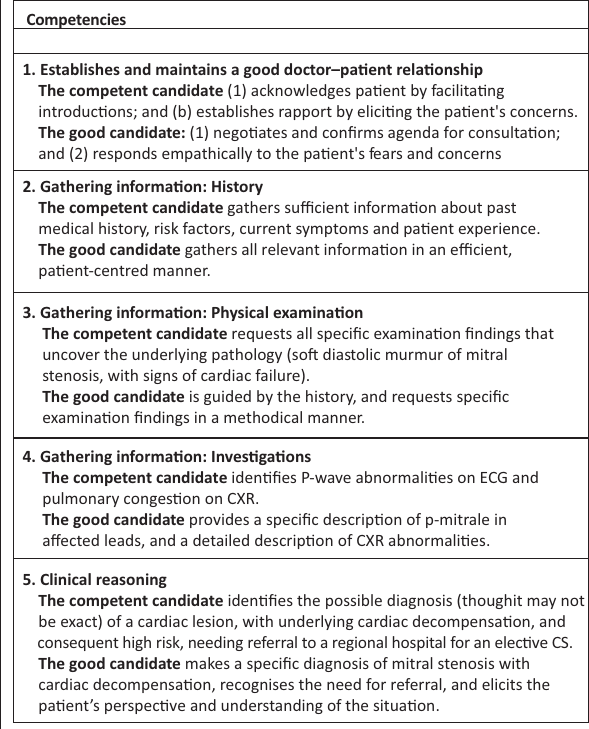
FIGURE 3: Guidelines for examiners to judge student